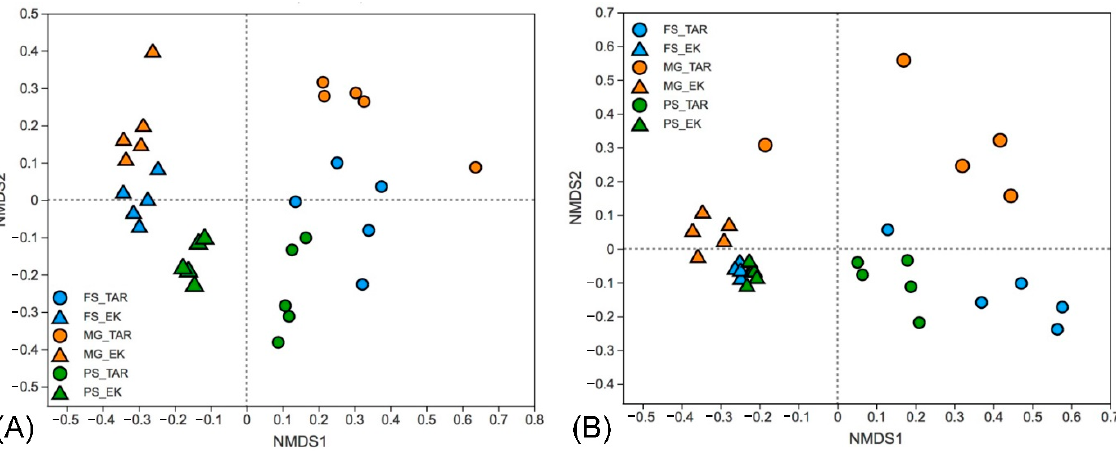
Figure 6. Heatmap of the 20 most abundant OTUs. Each column represents a sample and is grouped by different primer sets. The rows list the 20 most abundant phyla across the samples. Each OTU is assigned with its phylum. OTU1899 and OTU2365 are both assigned in the genus Stephanodiscus ; OTU2384 and OTU2357 are assigned in the genus Aulacoseira .